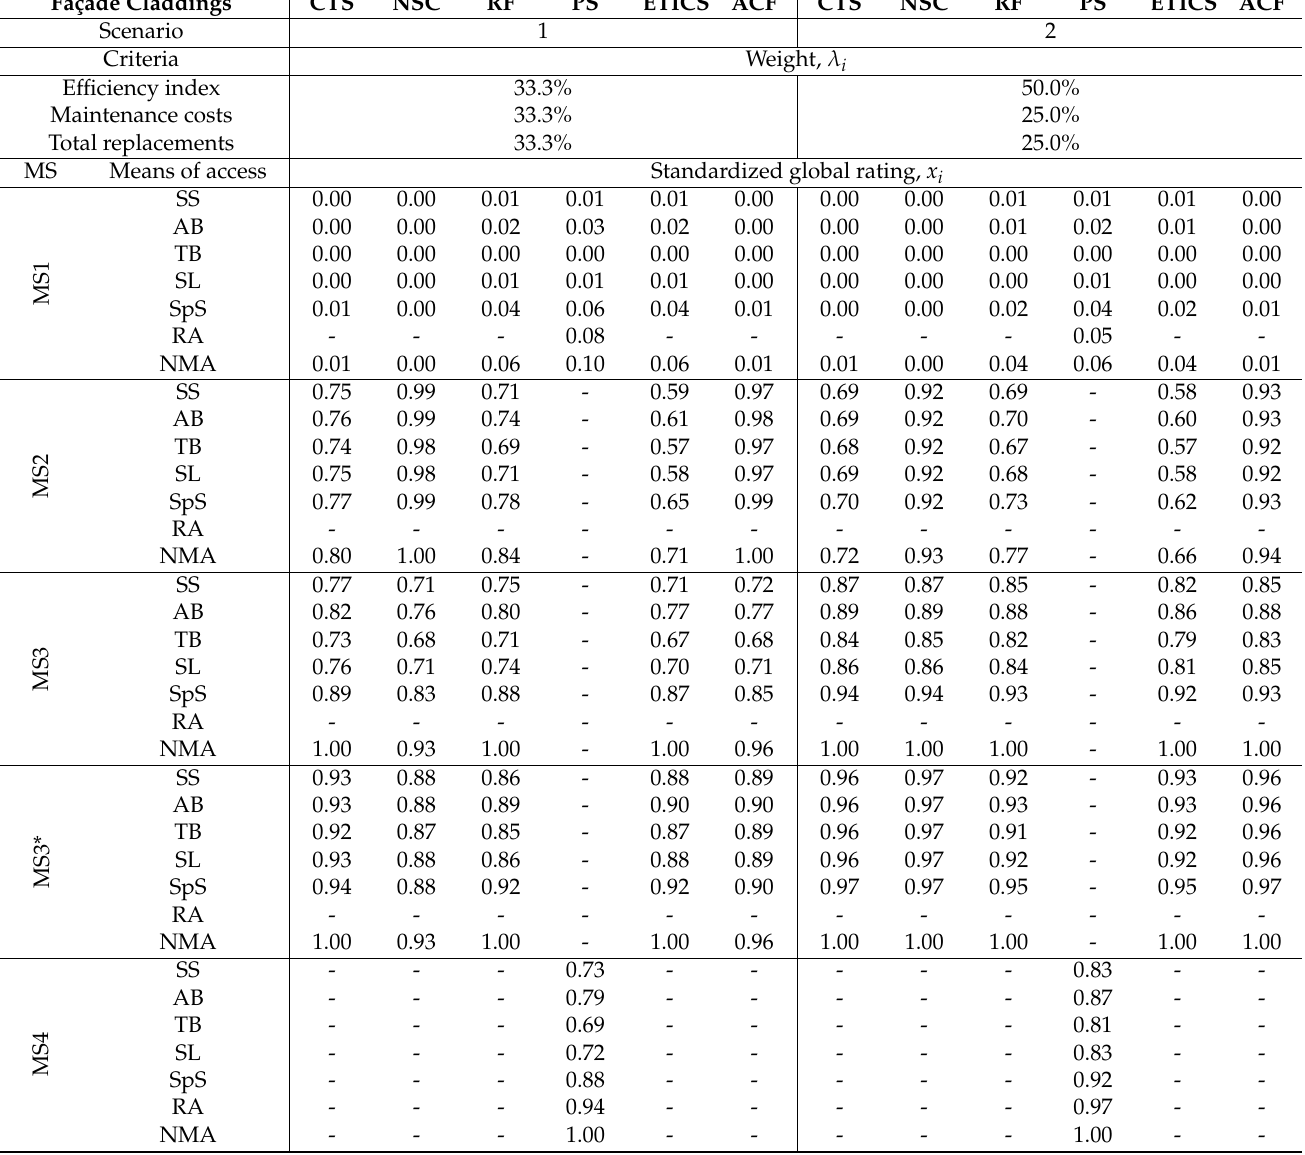
Table 3. Multi-criteria